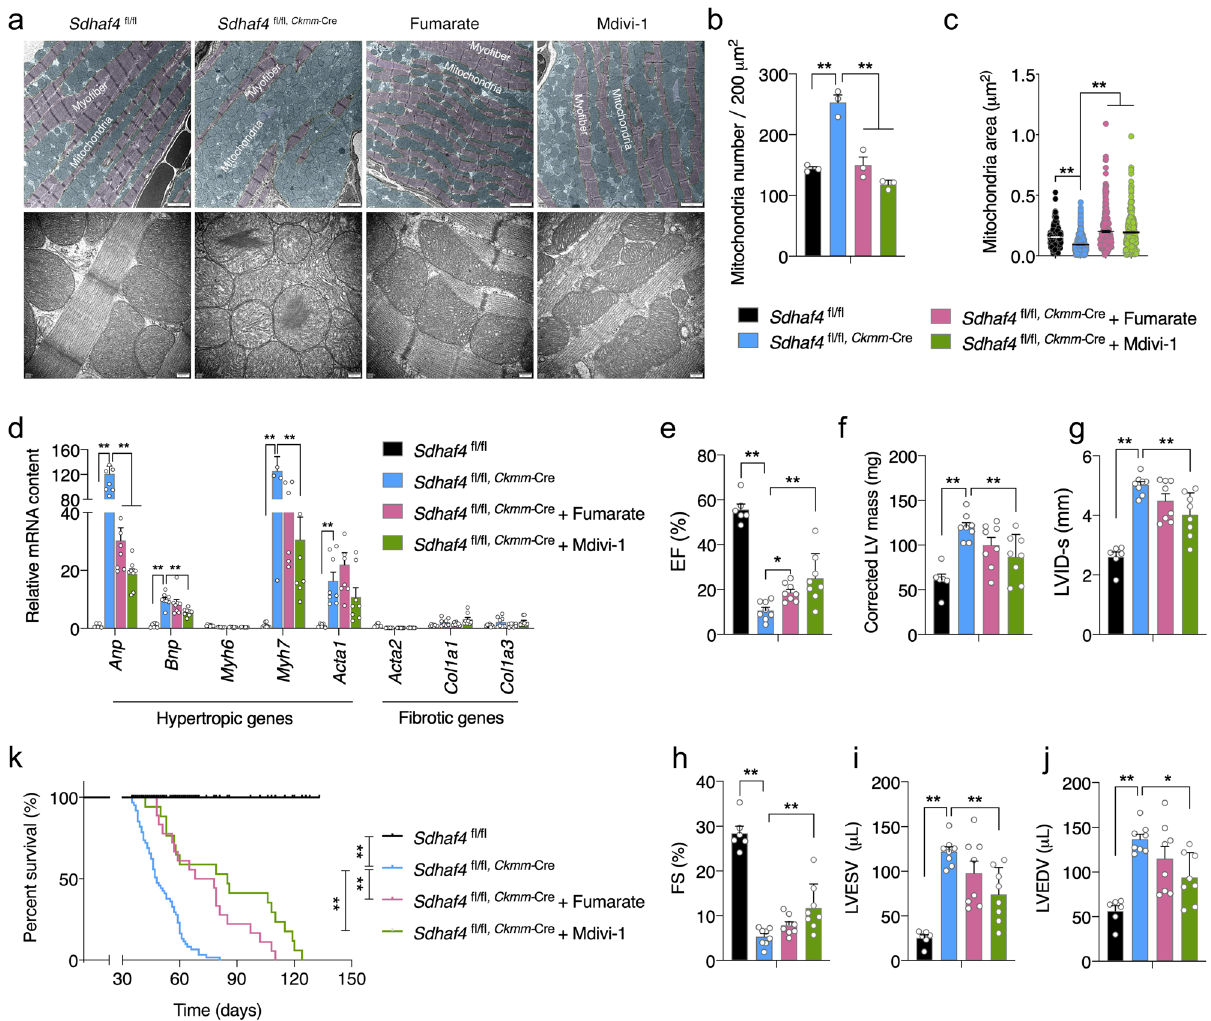
Fig. 7 Inhibition of Drp1 or supplement with fumarate prolongs lifespan of mice with dilated cardiomyopathy. a – c TEM analysis for left ventricles of hearts from WT, Sdhaf4 mutant mice, mutant mice with fumarate or Mdivi-1 supplement for 4 weeks, representative images ( a , scale bar, 1 μ m and 200 nm respectively), mitochondrial number per section ( b , n = 3, P < 0.0001), average mitochondrial area ( c , n = 293 for WT, n = 650 for mutants, n = 305 for fumarate, n = 230 for Mdivi-1, P < 0.0001). d Relative expression of hypertrophic and fi brotic-associated genes in left ventricle of hearts of mice ( n = 8,